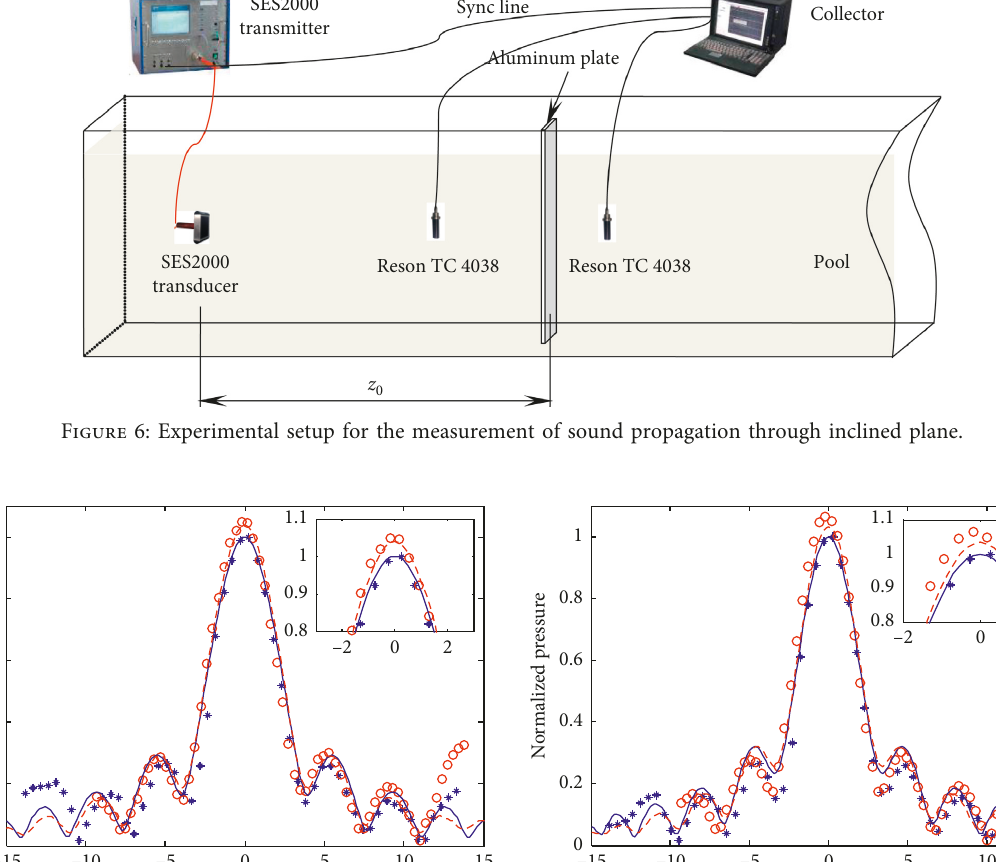
Figure 5: 2D sound pressure distribution at the center of water-ethanol boundary position ( z difference frequency; (c) sum frequency.